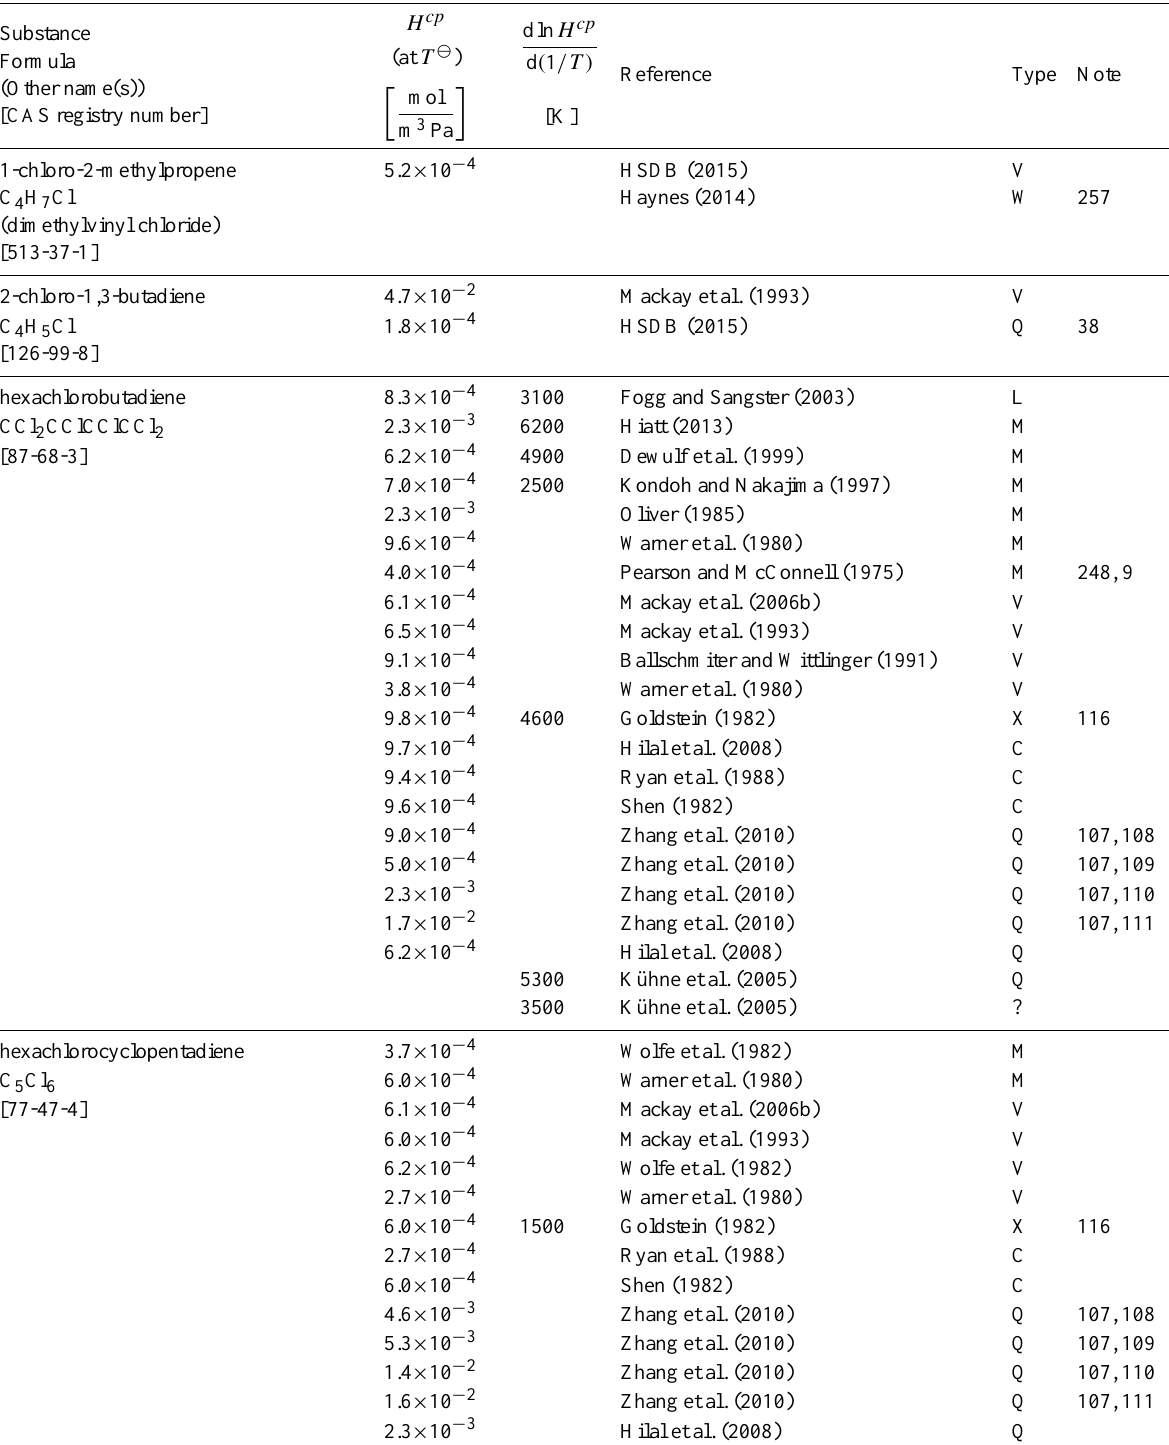
Table 6: Henry’s law constants for water as solvent